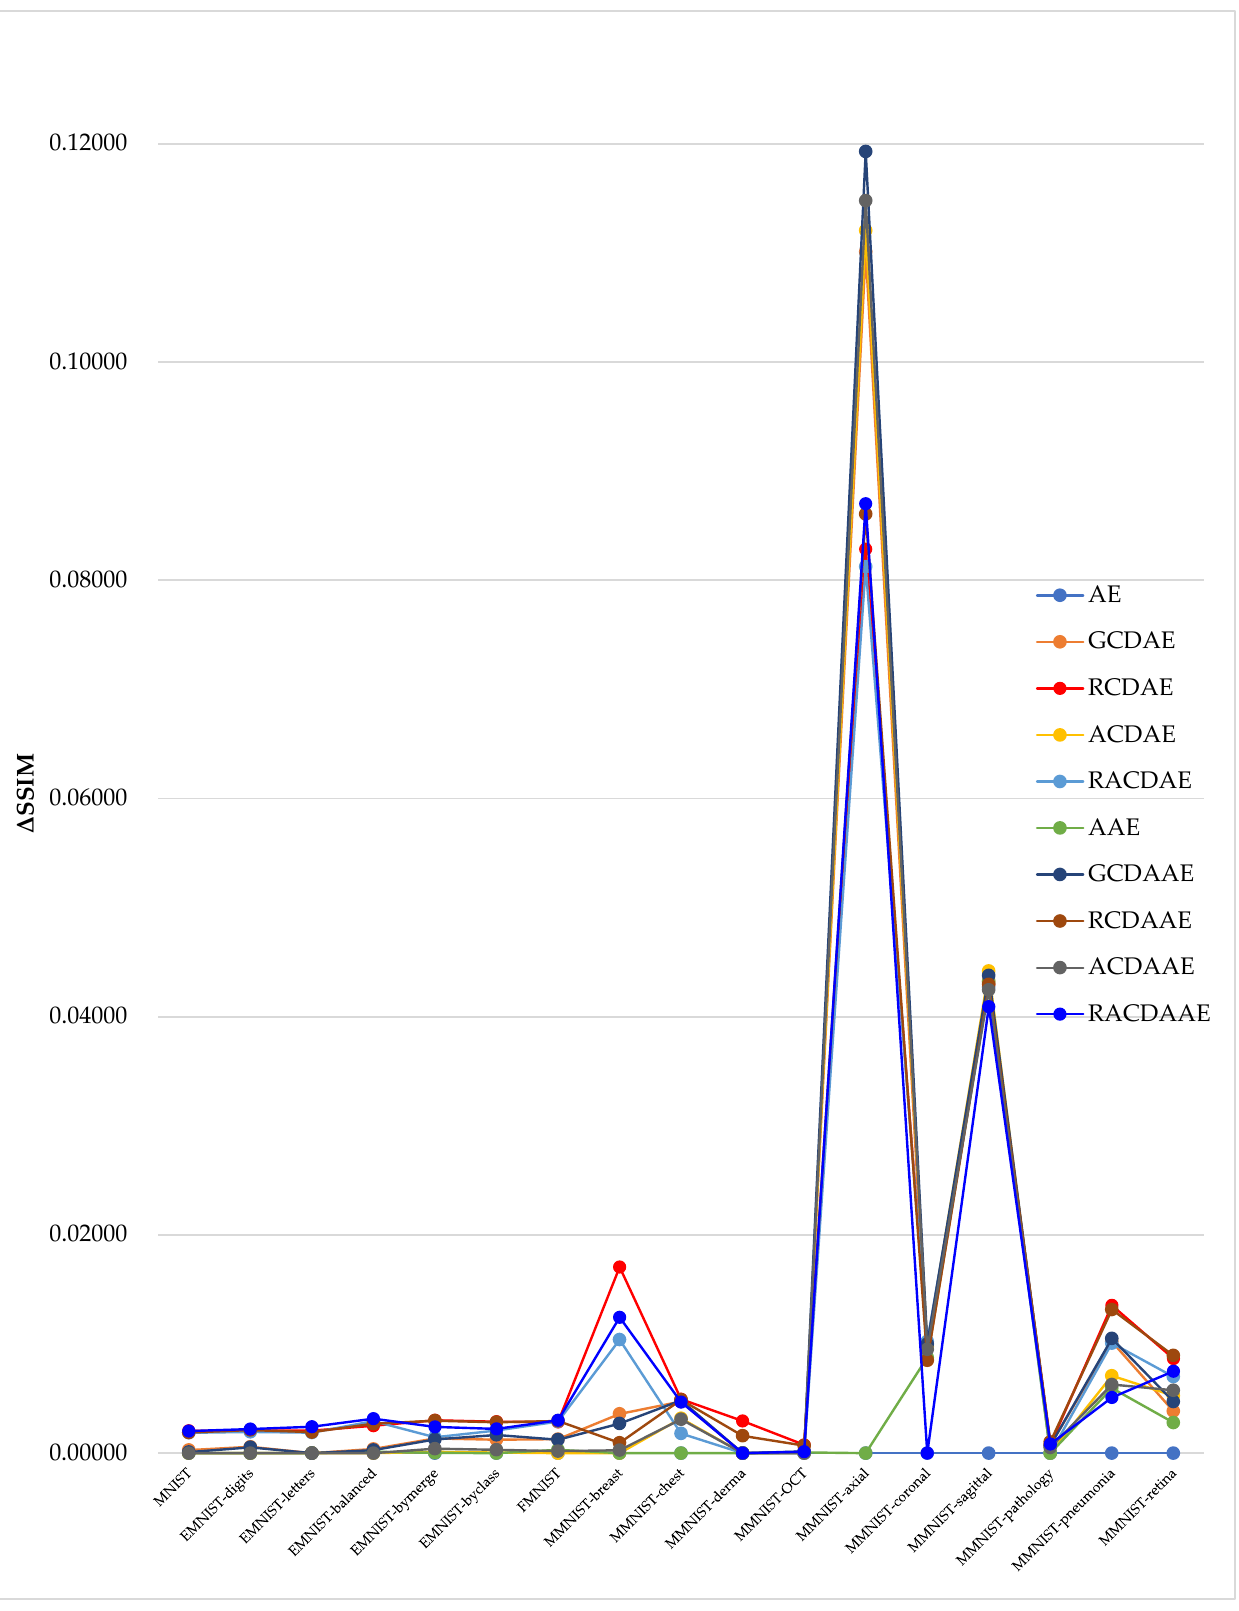
Figure 15. Experimental results of different algorithms on the four data sets.